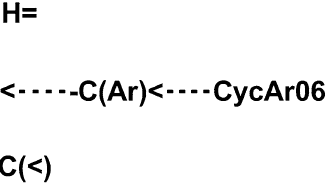
Table 3. Neural networks were obtained after iterative modeling. MLP-multilayer perceptron; k-m-1-the number of input, hidden and output neurons; BFGSN-an algorithm for finding the minimum of the error function; Exp, Tanh, Ident-activation functions of the hidden and output layers of neurons, exponential, hyperbolic tangent, identical, respectively.